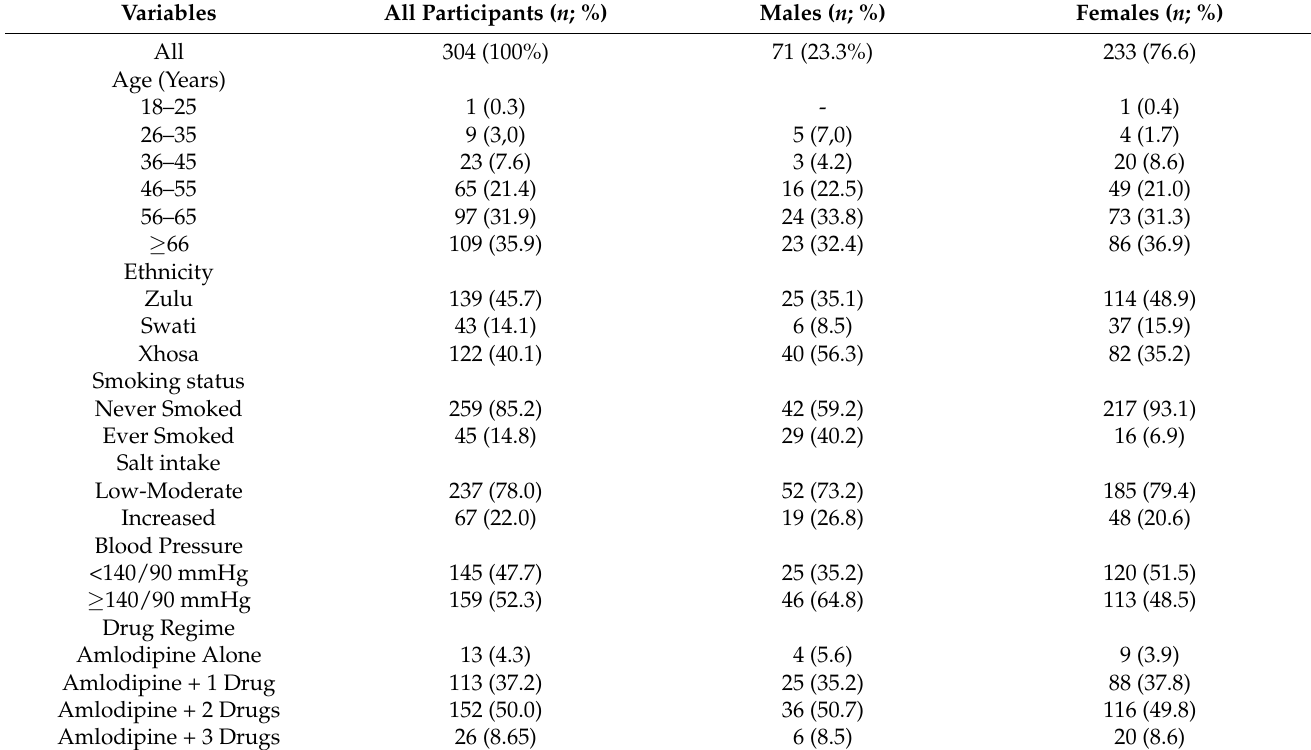
Table 2. General characteristics of study participants disaggregated by sex ( n =